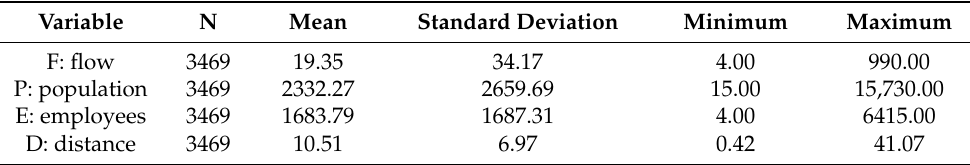
Table 4. Descriptive Statistics for Non-Zero Flows in 2000.